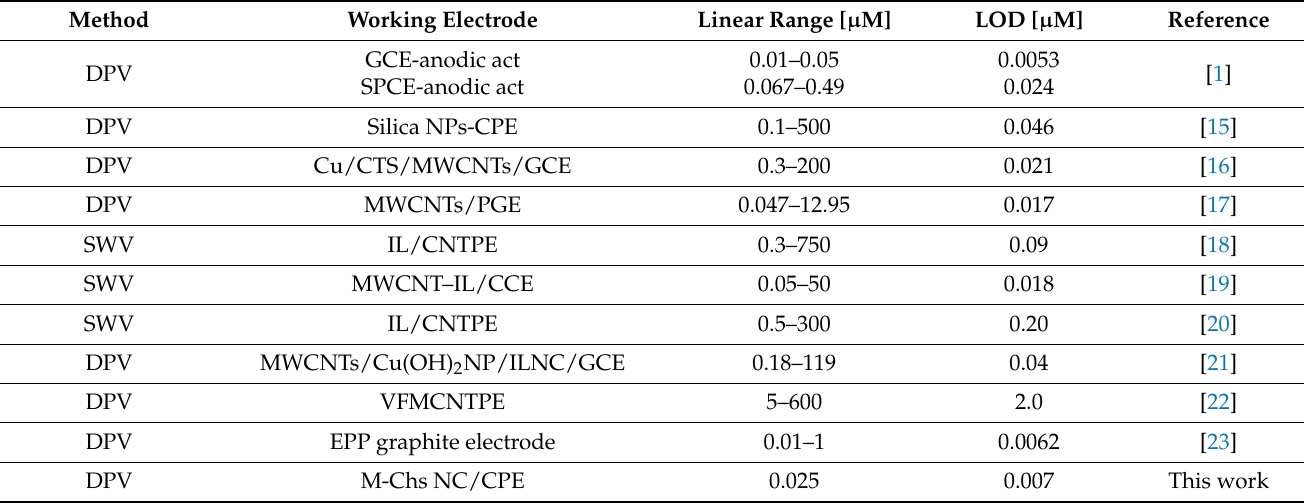
Table 1. Comparison of the linearity range and LOD for the determination of OFL and CIP using different